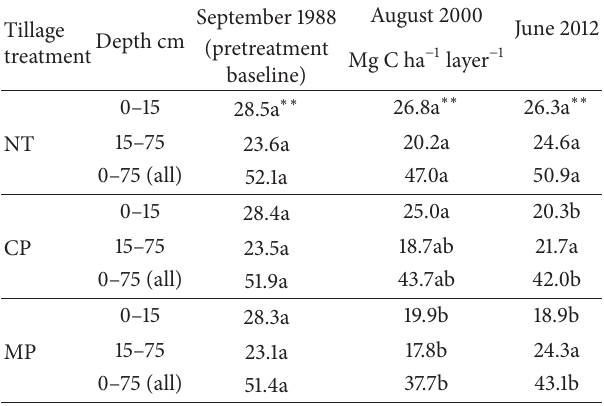
Table 6: Use of pretillage treatment 1988, 2000, and 2012 SOC during 24 years of tillage